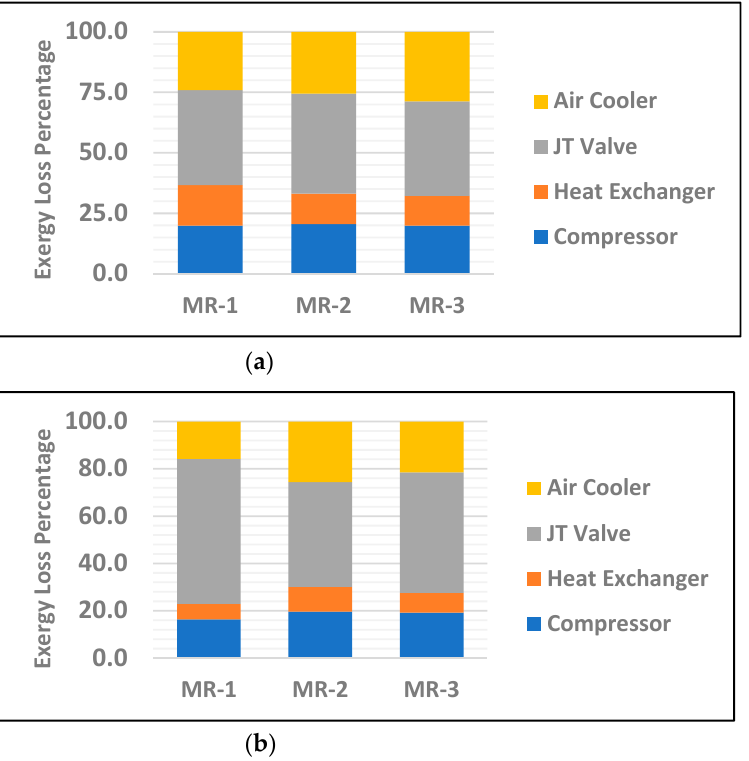
Figure 4. Exergy loss percentage of individual major equipment for the mixed refrigerants MR-1, MR-2 and MR-3 for; ( a ) base case with 20% NH 3 ; ( b ) 30% NH 3 . Table 7. Exergy loss of individual equipment of proposed NG pre-cooling cycle. Compressor Case No.